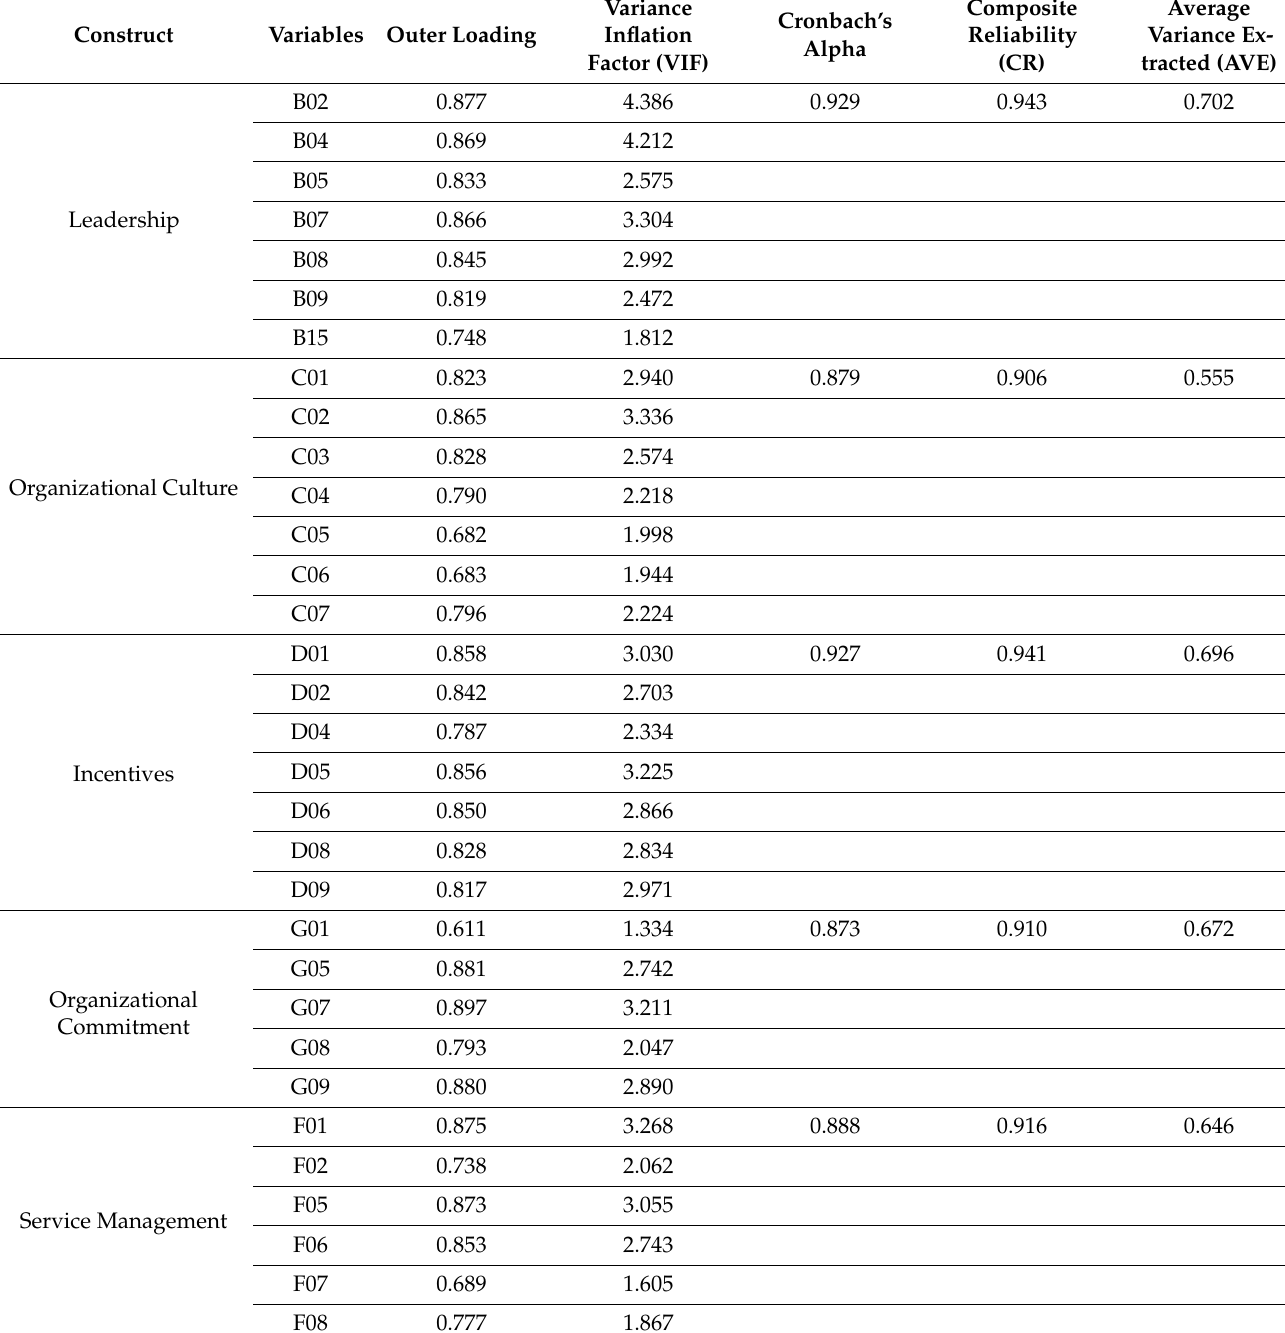
Table 2. Composite reliability (CR) and average variance extracted (AVE) of the